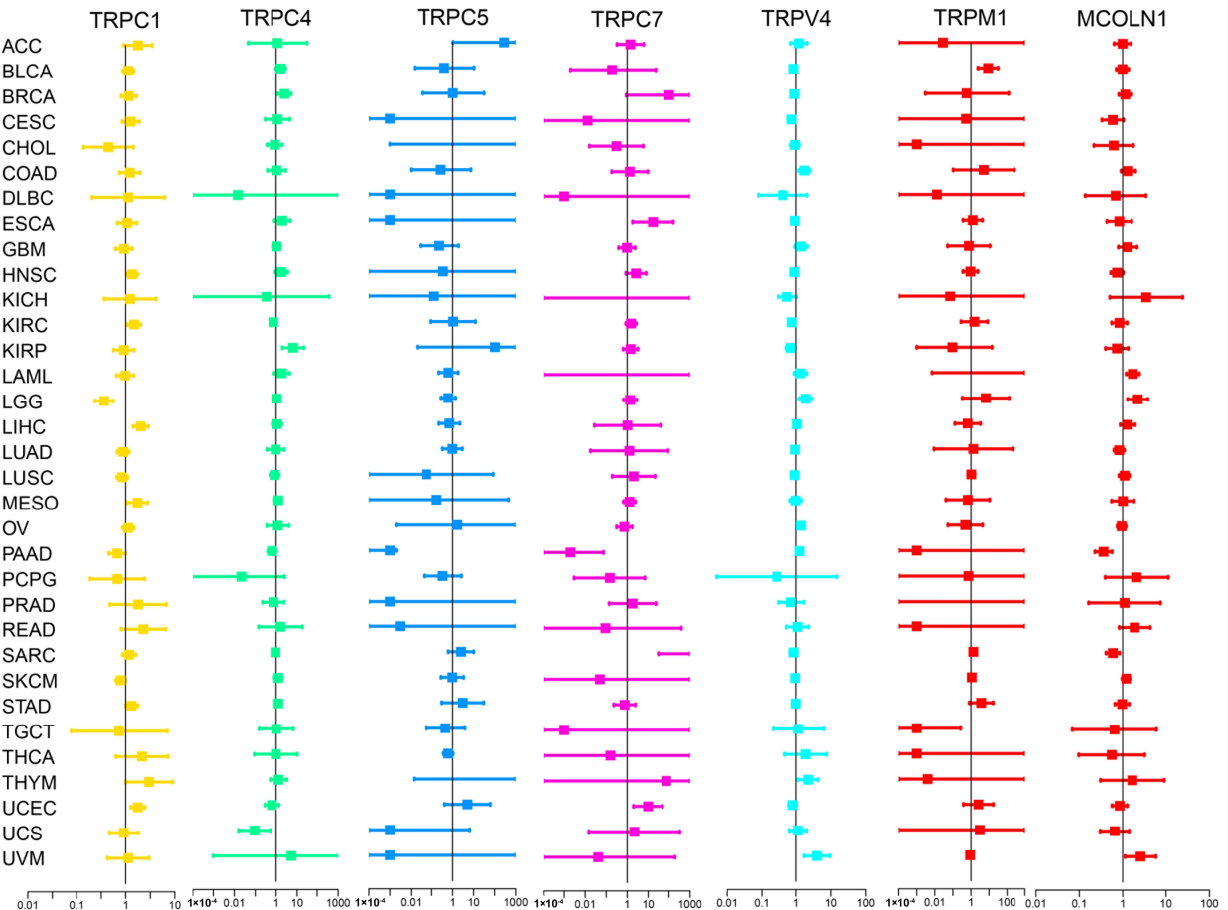
Figure 3. Cox regression analysis of the correlation between the expression of TRP family genes and survival. Lines with different colors represent the risk values for different genes within the tumor, with a hazard ratio <1 and >1 indicating low and high risk, respectively.